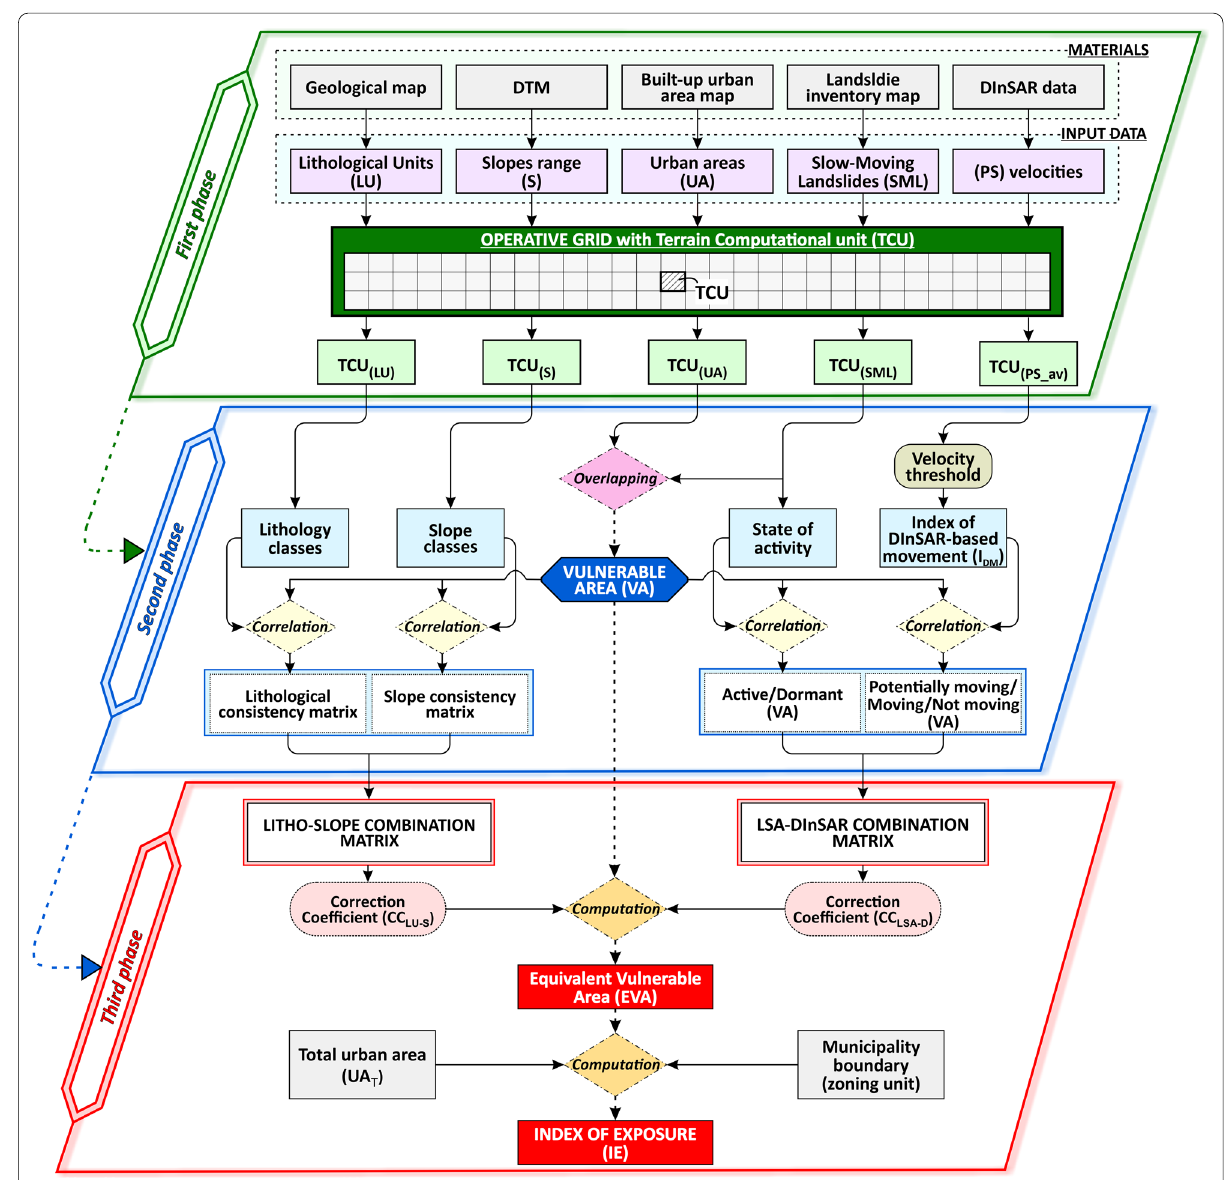
Fig. 1 Flowchart of the proposed method to rank zoning units exposed to slow-moving landslide (SML) risk at small